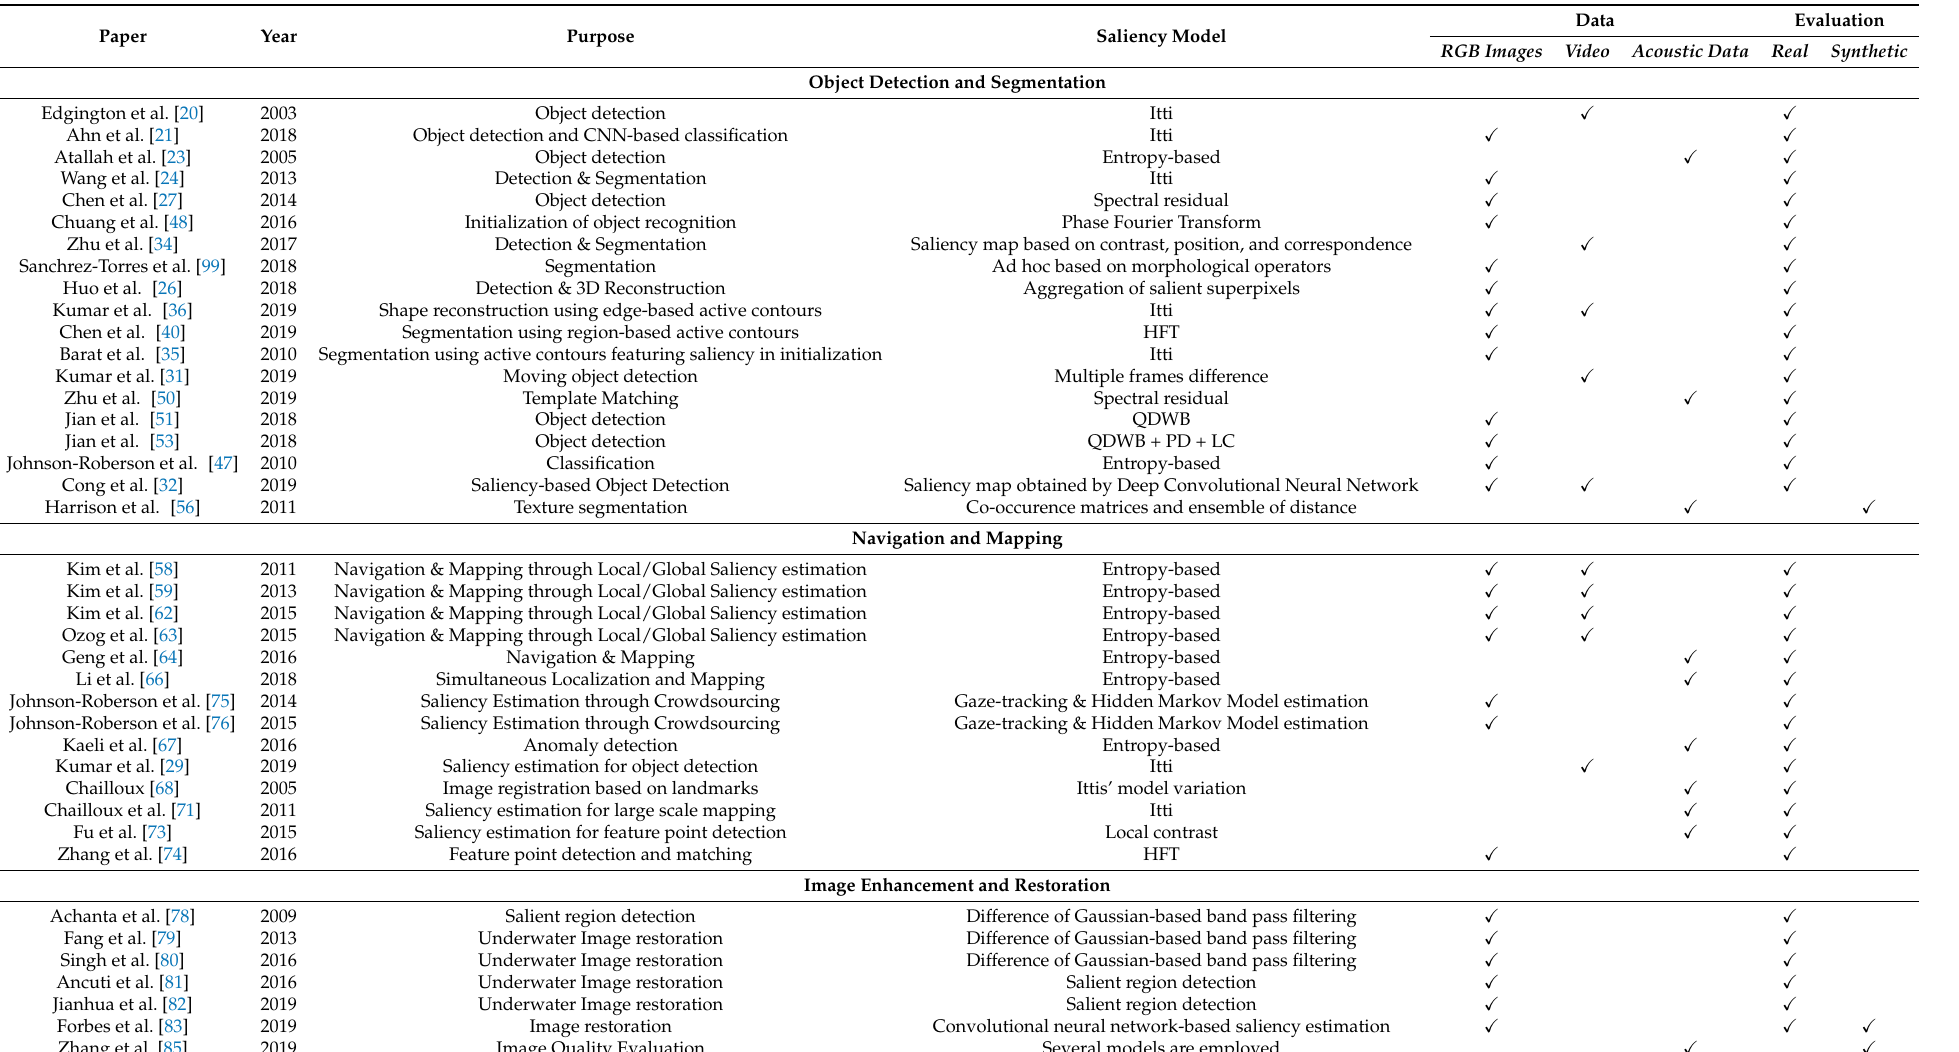
Table 1. Summary of surveyed